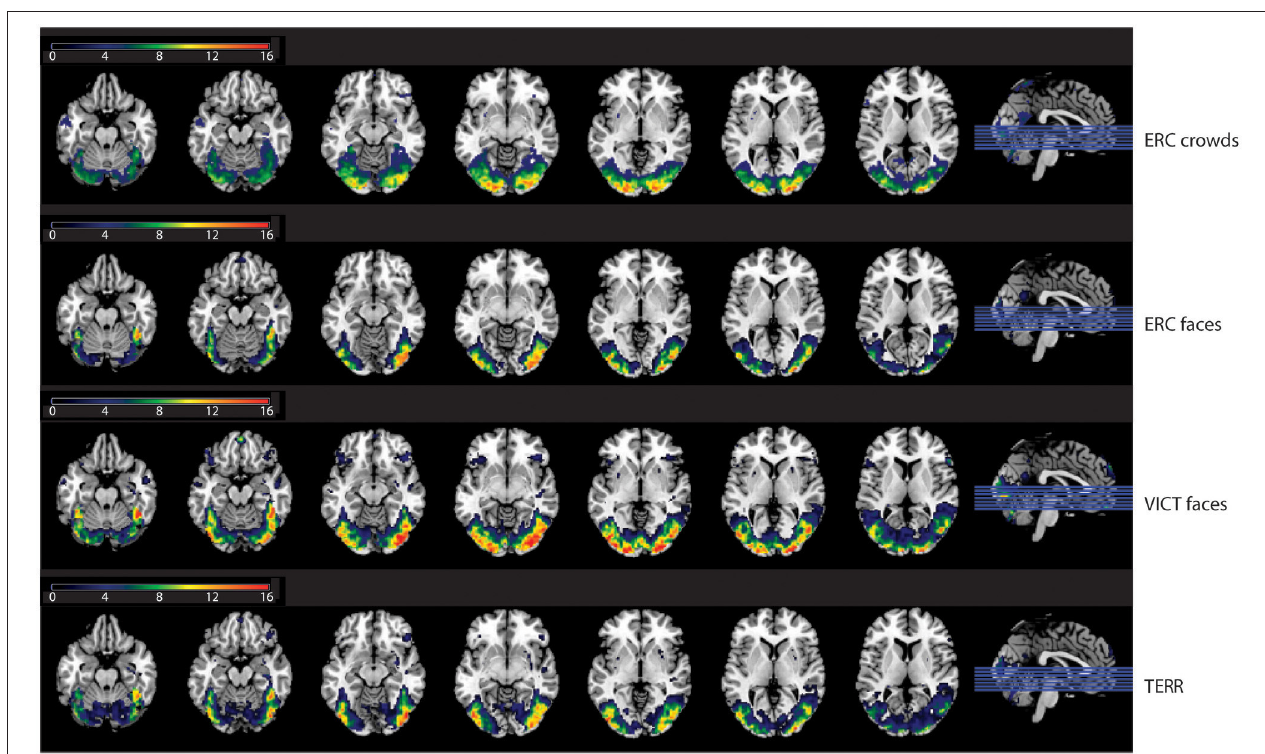
FIGURE 5 | The effect of the content of the documentary photographs on brain activity. The results are mapped on an anatomical template (MNI z = − 22, − 17, − 12, − 7, − 2, 3, 8, FWE p ≤ 0.05). The color bars on the left show t -values. ERC FACES, European refugee crisis with close-ups of emotional faces; ERC crowds, European refugee crisis showing an anonymous crowd; TERR, Islamic terrorists in a threatening pose; VICT FACES, victims of natural disasters or accidents with close-ups of emotional faces. The images were rendered using MRIcron software and ch2bet brain template (https://www.nitrc.org/projects/mricron/).